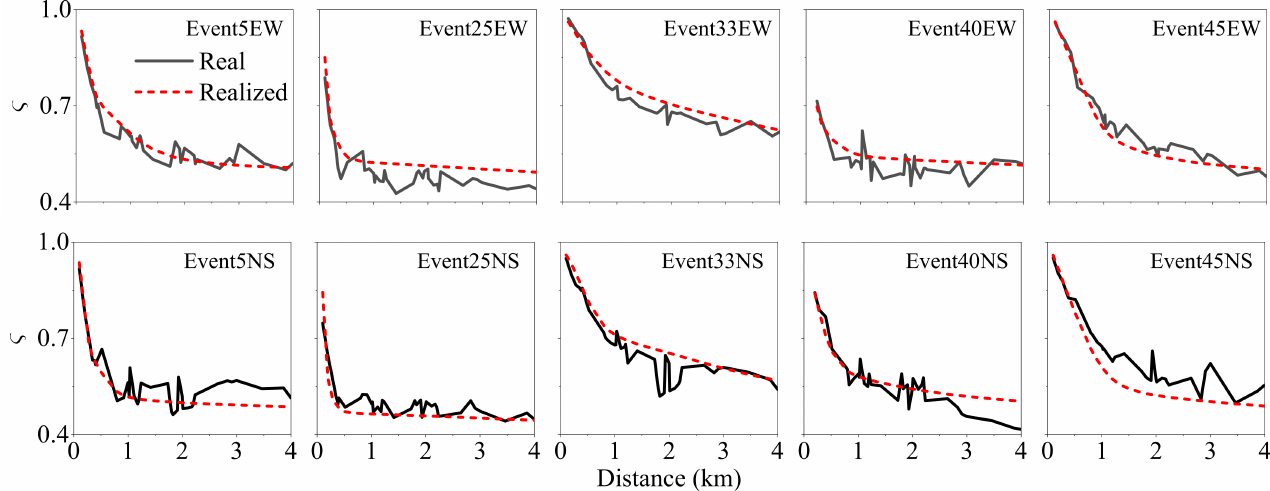
Figure 19. Realized similarities by the general parametric model.